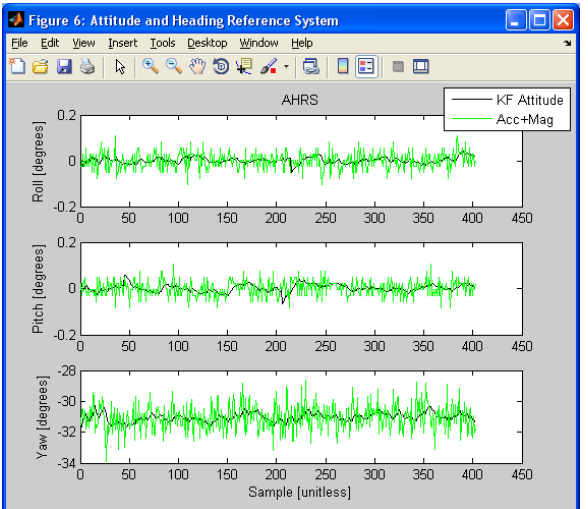
Figure 5. AHRS’ attitude estimation